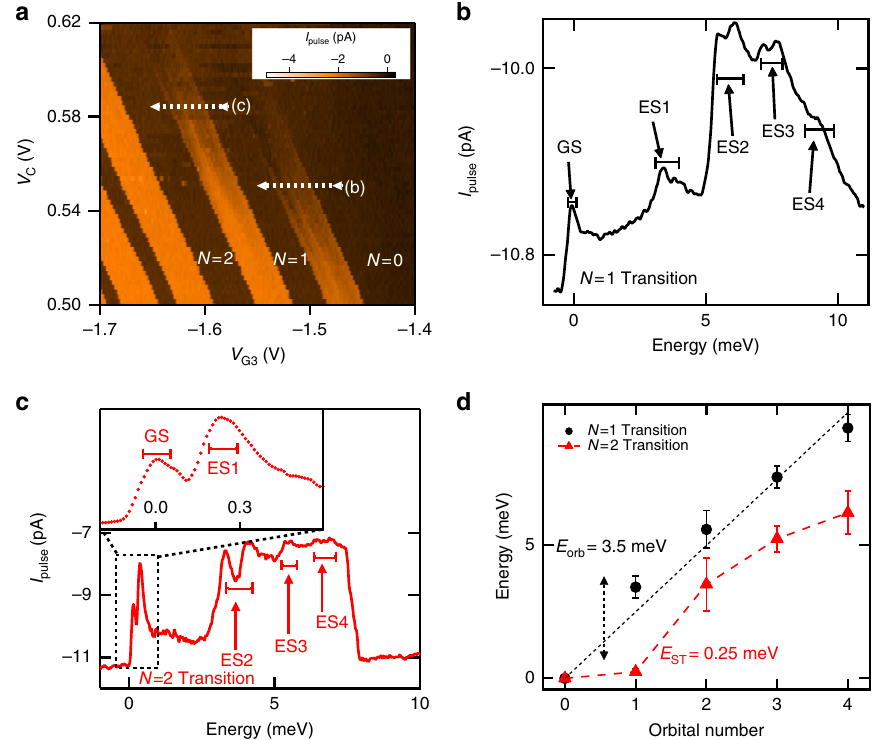
Fig. 3 Excited state spectroscopy. a Charge stability diagram for V pulse = 40 mV and f pulse = 333 Hz. The white dashed lines (labeled (b), (c)) correspond to the region where high resoloution cuts are taken to obtain the data in b and c , respectively. b Measurement of I pulse over the N = 0 → 1 Coulomb peak. The x -axis has been converted to energy using the lever arm (Supplementary Note 4). The ground state (GS) and excited states (ES1 – 4) for the one-hole system are labeled, with the brackets indicating the experimentally determined width of each peak. Additional structure is observed for ES2 and ES3, see text. c Same as b for the N = 1 → 2 Coulomb peak. The inset demonstrates that the ground state and fi rst excited state are resolvable. Each dot represents a single data point. d Plot of the extracted excited state energies for the one-hole (black) and two-hole (red) system. The black dashed line is a straight line fi t to the N = 1 data, highlighting the linear dependence of the excited state energies on the orbital number. The red dashed line is a trend line connecting all the measured N = 2 data points (red triangles). The black and red error bars correspond to the width of the black and red brackets in b , c respectively. See Methods section for additional experimental